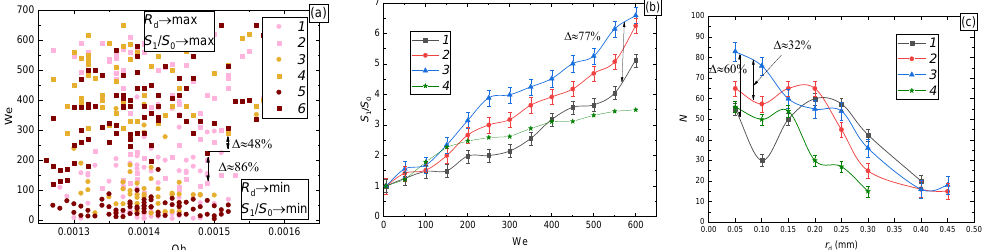
Figure 7. ( a ) Regime map of the drop impact on the wall (circle — deposition of the first drop and coalescence with all others, square — breakup) as a function of We(Oh): 1, 2 — R a = 0.01; 0.008 µm; R z = 0.05; 0.04; 0.032 µm; 3, 4 — R a = 2.5; 1.25 µm; R z = 10; 8; 6.3 µm; 5, 6 — R a = 20; 16;10 µm; R z = 80; 63; 50; 40 µm; ( b ) S 1 / S 0 (We); ( c ) size distribution of child droplets at different surface roughness: 1 — R a = 0.01; 0.008 µm; R z = 0.05; 0.04; 0.032 µm; 2 — R a = 2.5; 1.25 µm; R z = 10; 8; 6.3 µm; 3 — R a = 20; 16;10 µm; R z = 80; 63; 50; 40 µm; 4 — smooth surface.